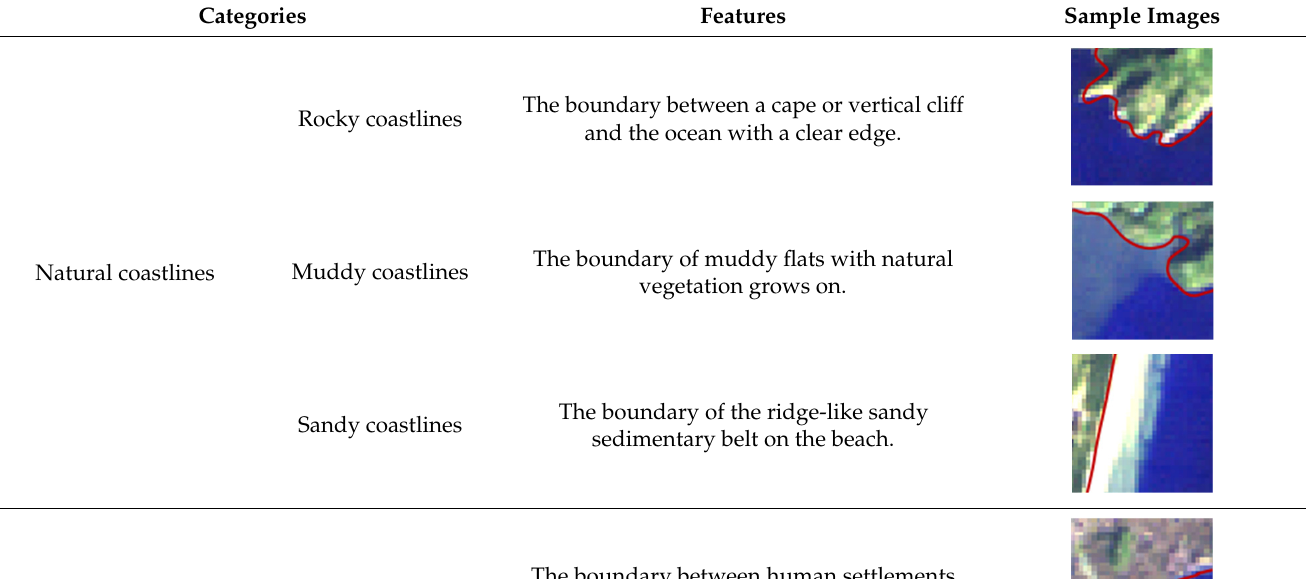
Table 2. Categories of continental coastline in Fujian Province.